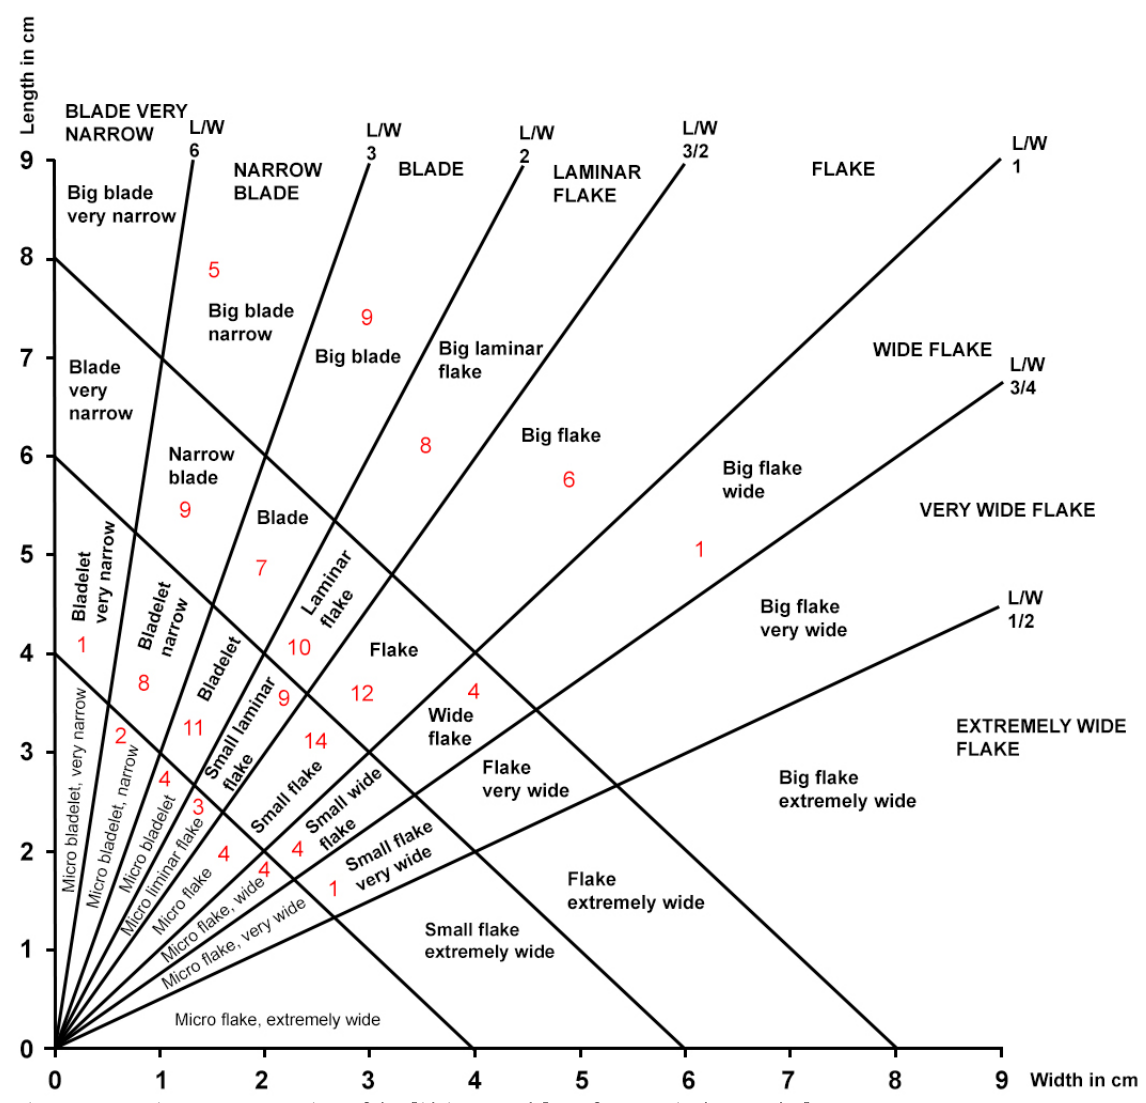
Figure 5. Laminar representation of the lithic assemblage from Tajo de